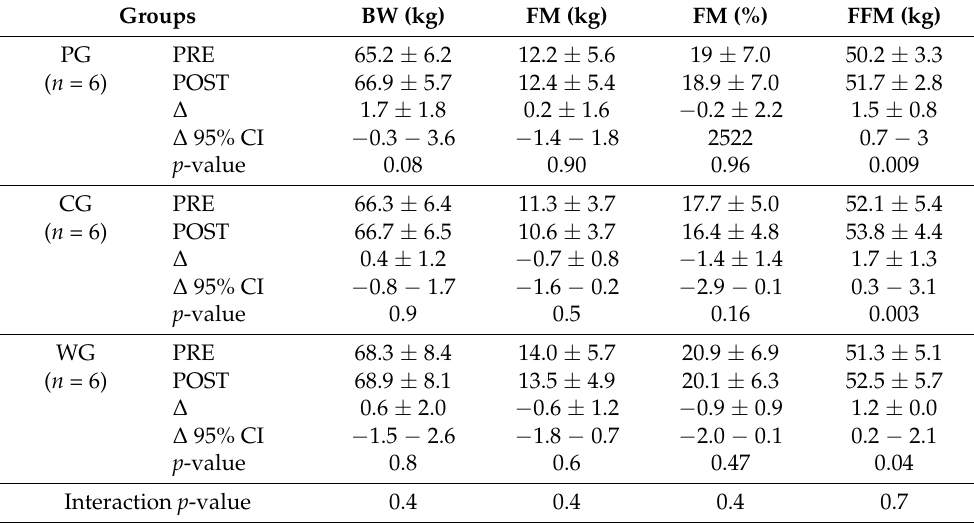
Table 5. Body composition before (PRE) and after (POST) an 8-week resistance training program in the placebo (PG), chia flour (CG) and whey protein (WG)